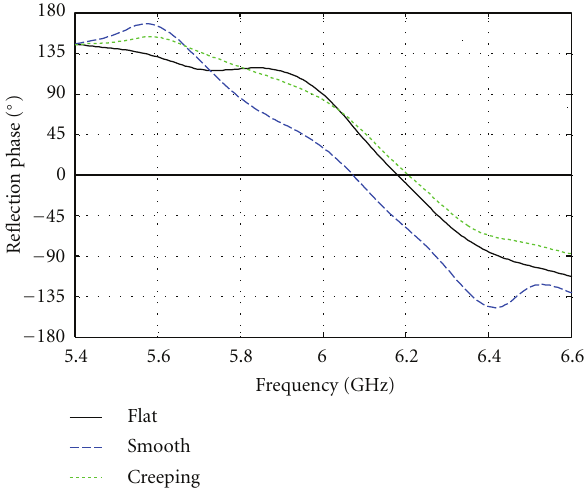
Figure 8: Reflection phase of the manufactured flat prototype for di ff erent incident angles ( θ inc ).